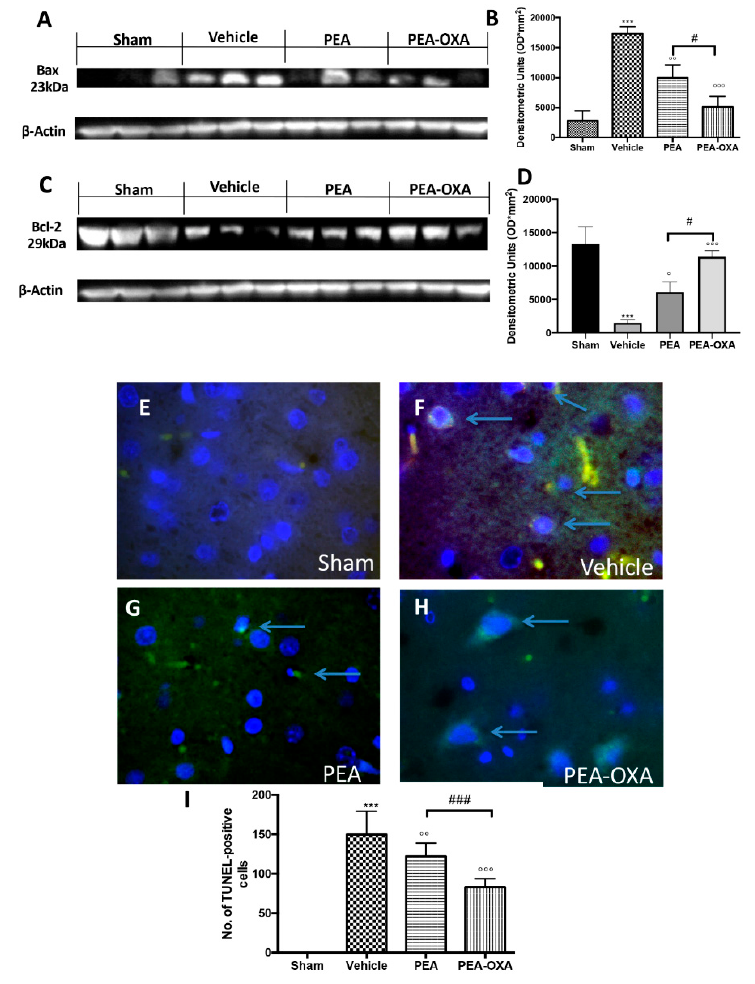
Figure 4. E ffi cacy of PEA-OXA on apoptosis induced by transient MCAo. In western blot Figure 4. Efficacy of PEA-OXA on apoptosis induced by transient MCAo. In western blot analyses, a minimal expression of Bax in brain samples taken from sham rats was detected. PEA-OXA was able